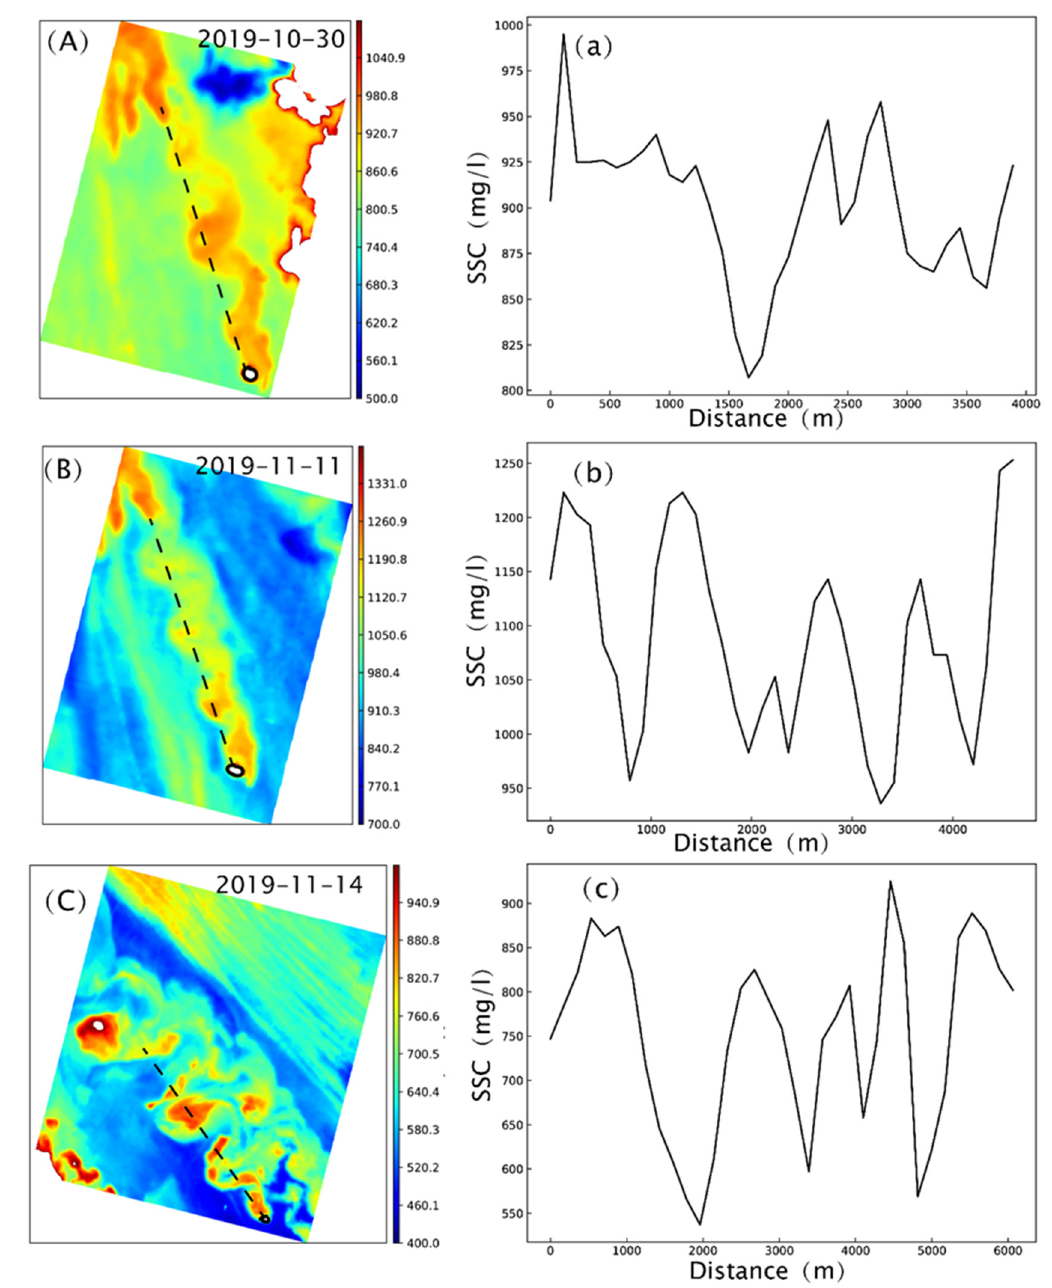
Figure 5. The changes in SSC in the Karman vortex street observed in HY-1C CZI images (( A–C ): The distribution of SSC in the vortex street; (a–c): the change in SSC sampled downstream of the vortex street; the dotted line in ( A–C ): sampling trajectory).